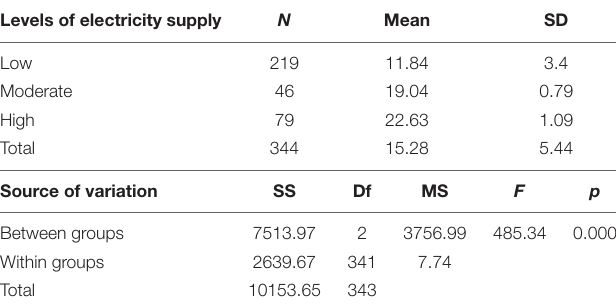
TABLE 7 | One-way analysis of variance of the mean difference in ICT deployment by academic staff based on the degree of electricity